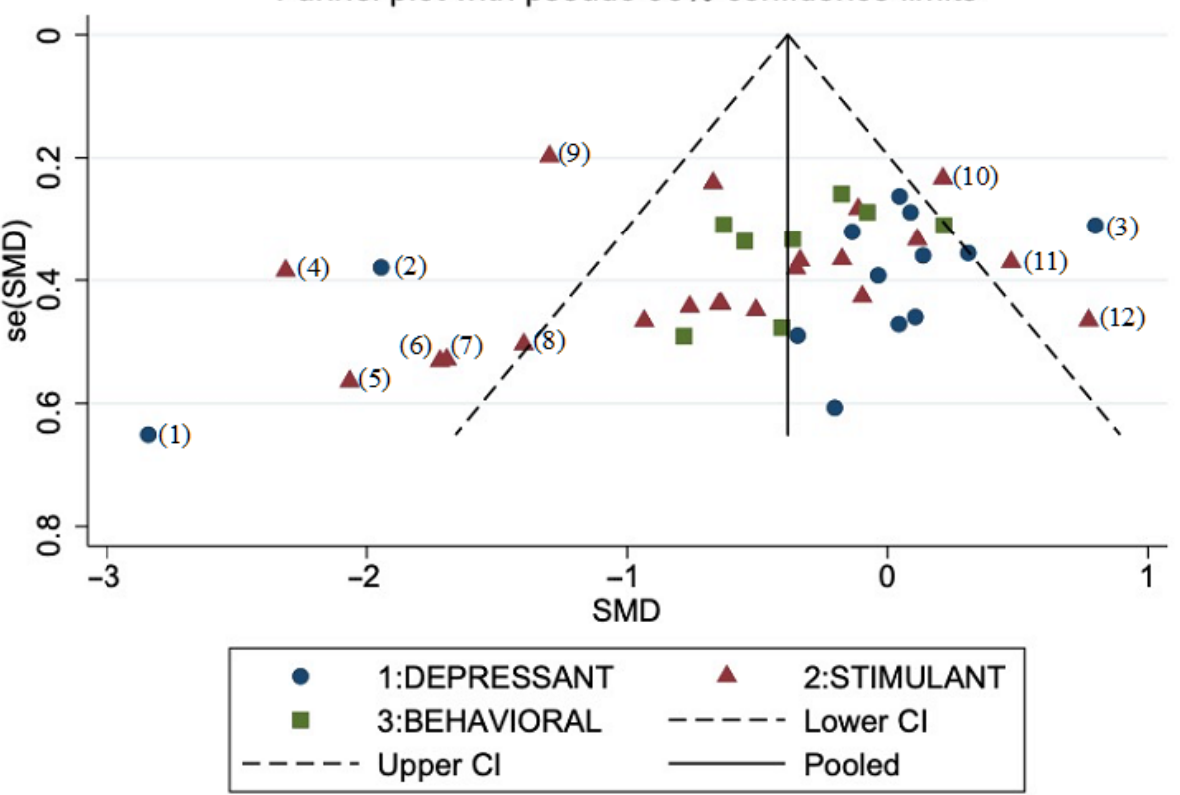
Figure 4. Funnel plot for publication bias of the included studies (42 units of analysis). (CI, confidence interval; SE, standard error; SMD, standard mean difference). Type of addiction: depressant (alcohol, cannabis, opiate); stimulant (nicotine, cocaine, methamphetamine); behavioral (eating disorder, gambling disorder). Outlier studies excluded from sensitivity analysis: (1), [108]; (2), [106]; (3), [86]; (4), [84]; (5 – 8), [85]; (9), [110]; (10), [95]; (11), high frequency arm from [88]; (12), [89].